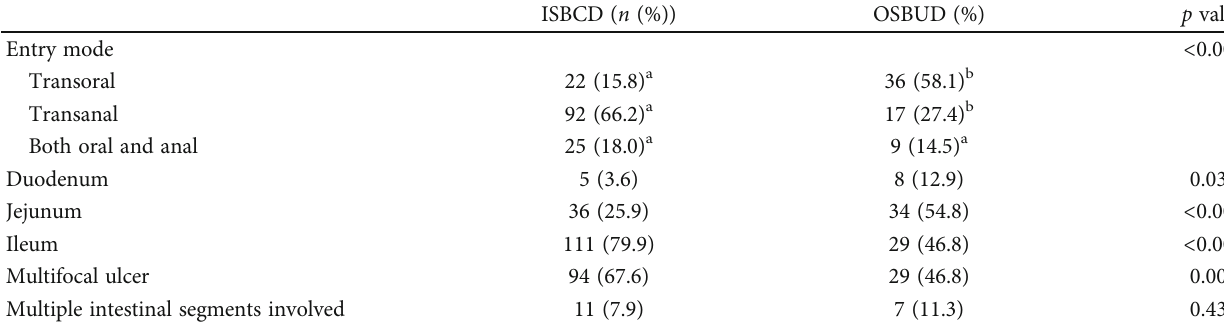
Table 5: Entry mode and ulcer distribution.